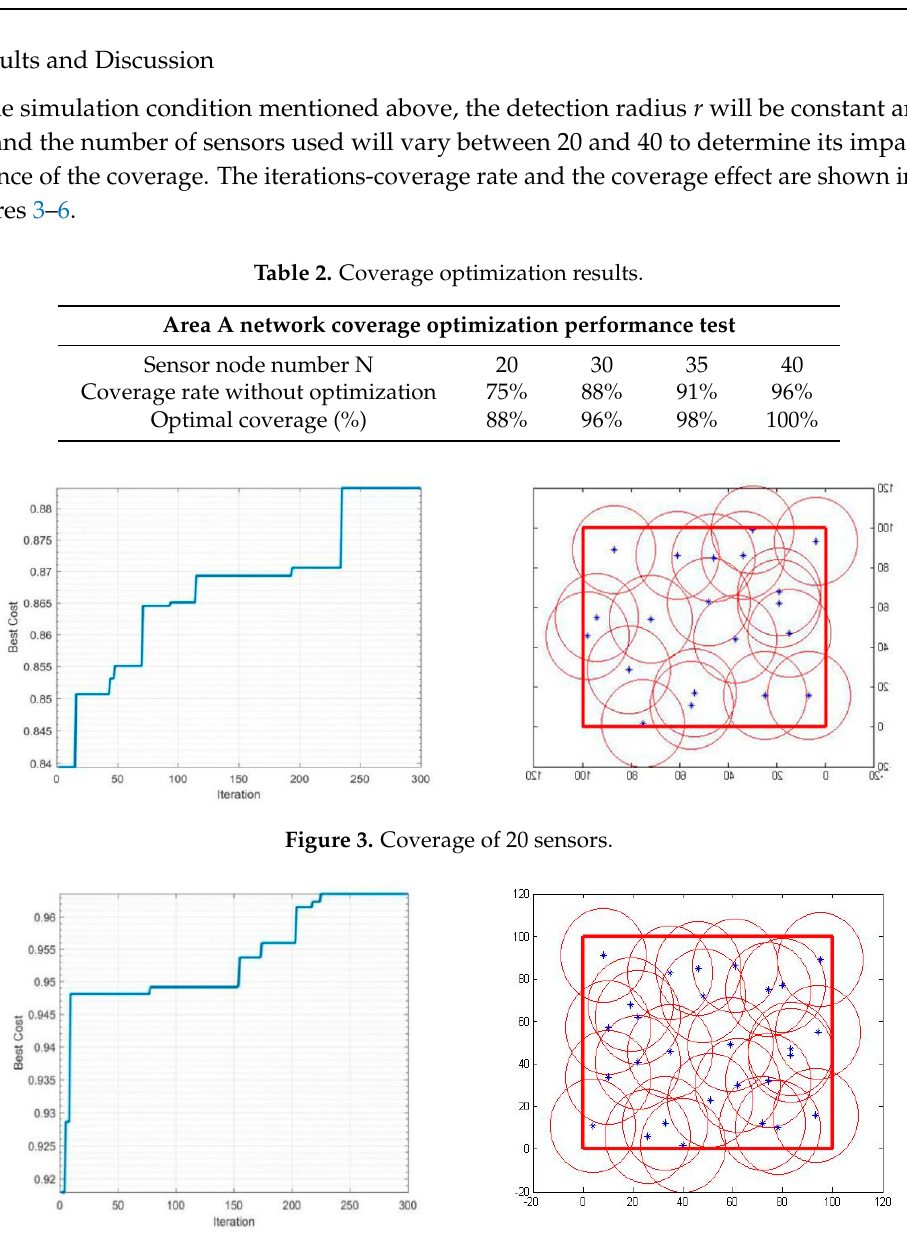
Figure 4. Coverage of 30 sensors.